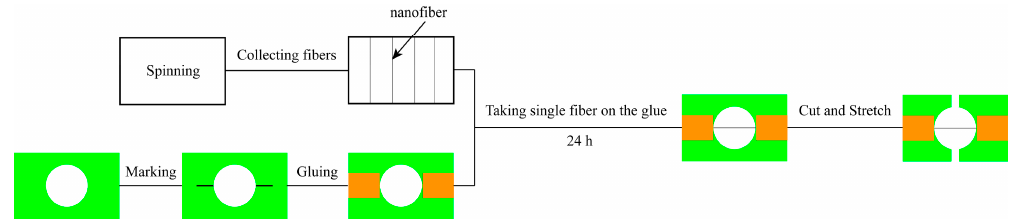
Figure 2. The flow chart for the preparation of single fiber tensile sample.